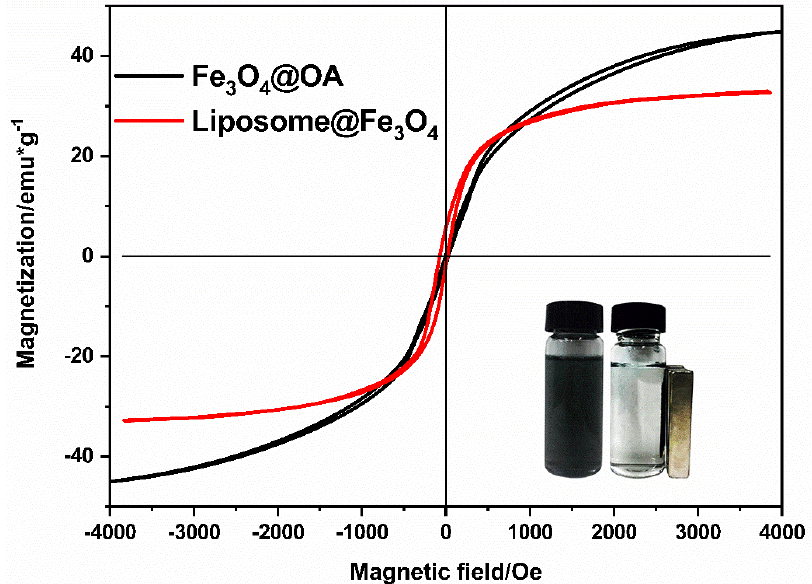
Figure 6. Magnetization curves of Fe 3 O 4 @OA nanoparticles and liposomes@Fe 3 O 4.